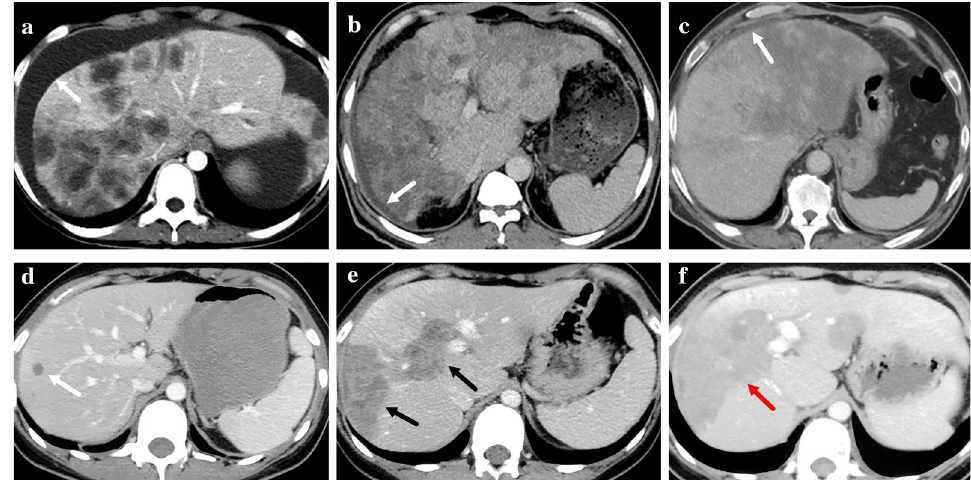
Fig. 6 a–c Perihepatic effusion of three HEH patients on CT scan (marked with white arrows). d–f The changes of CT appearances of a 28-year-old male HEH patient. During the period of 6 years follow-up, the patient received no treatment. d At the time of diagnosis, nodular lesion could be found (marked with a white arrow). e The CT scan at 4 years after the diagnosis showed locally coalescent lesions (marked with black arrows). f The CT scan at 6 years after the diagnosis showed diffusely coalescent lesion (marked with a red